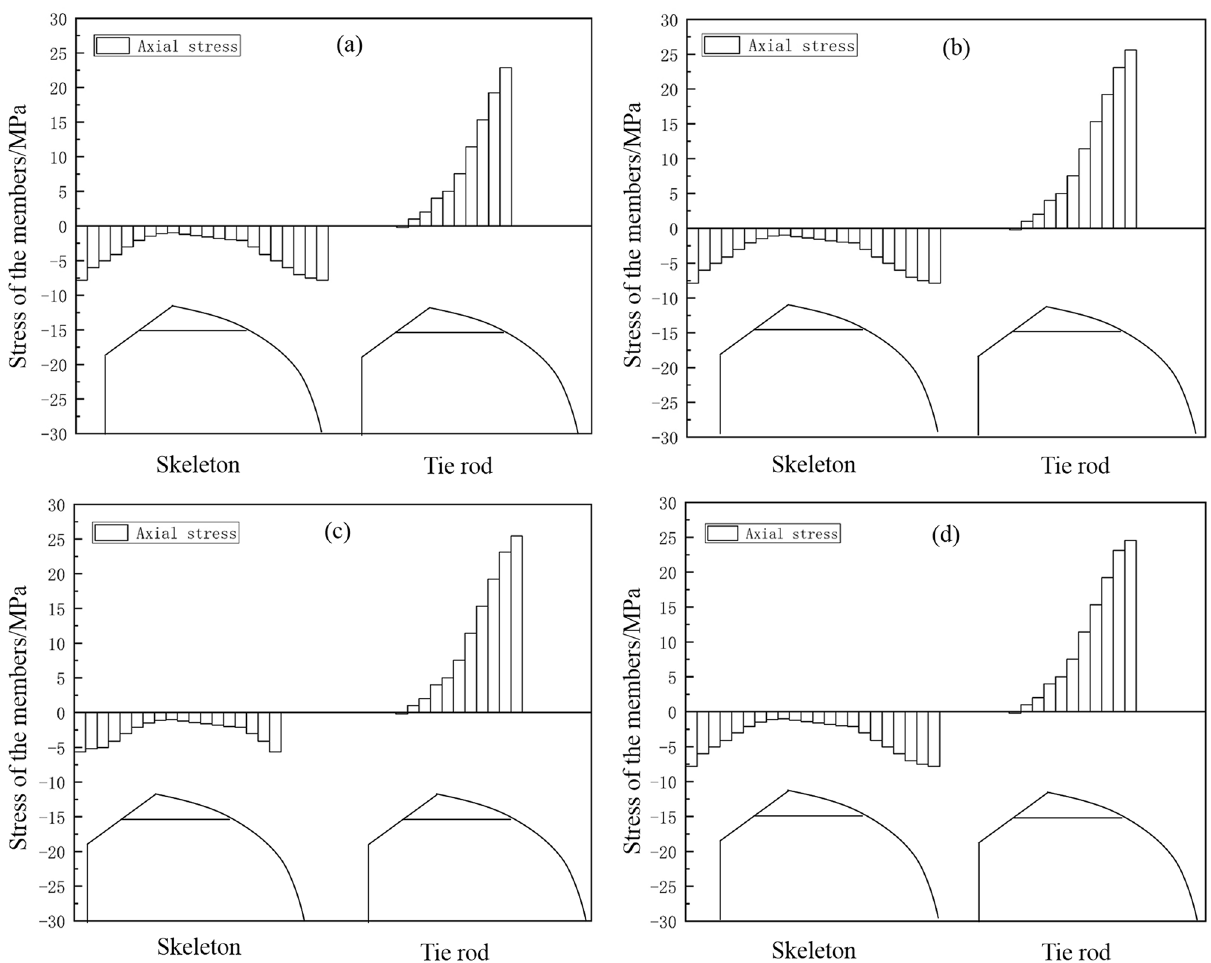
Figure 6. Normal skeleton stress diagram under uniform snow load condition: ( a ) round tube; ( b ) square tube; ( c ) Ω tube; ( d ) elliptic